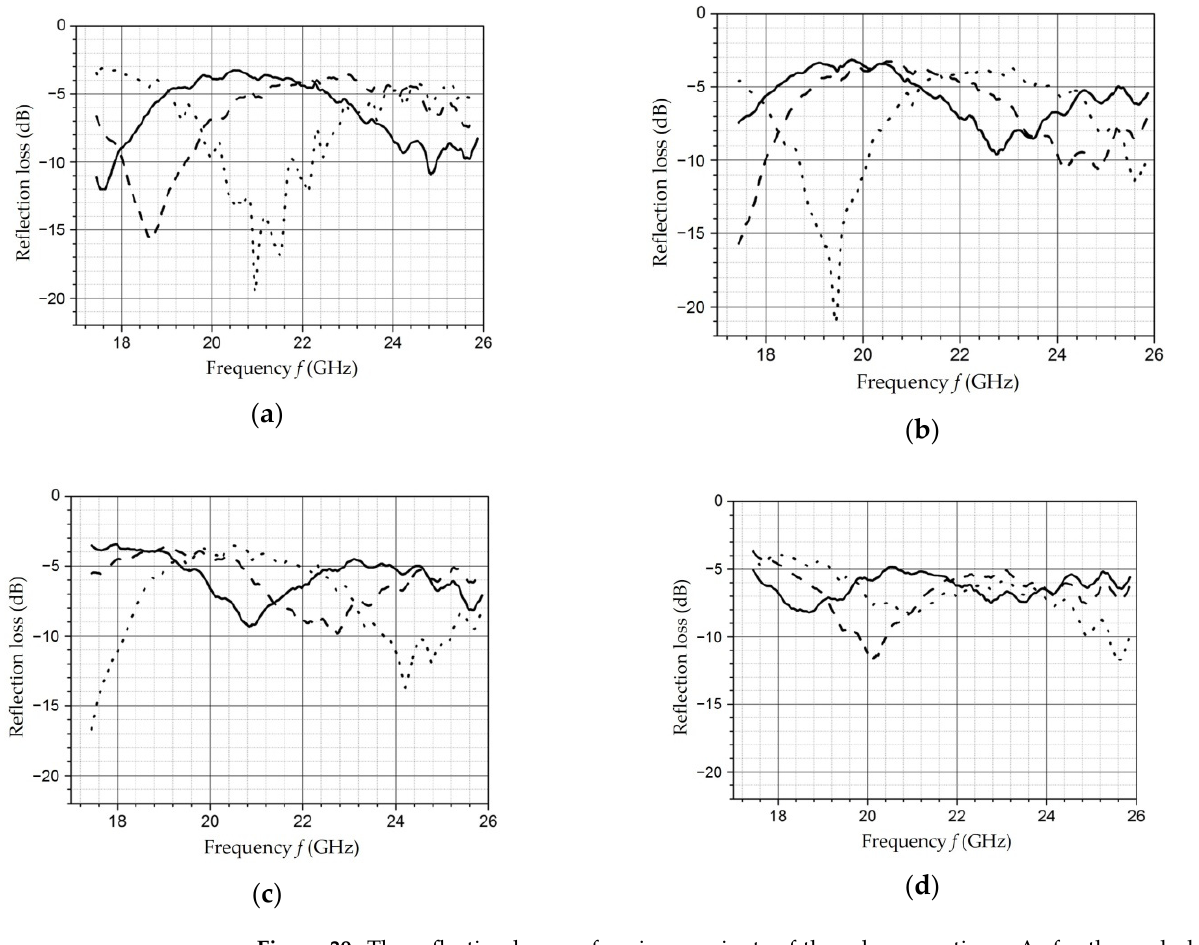
Figure 39. The reflection losses of various variants of three-layer coatings. As for the underlying dielectric layer with ε ≈ 4–10, the composition of the filler was varied, such as ( a ) no filler, ( b ) BaTiO 3 , ( c ) BaTiO 3 + CG, and ( d ) BaTiO 3 + AMAG.